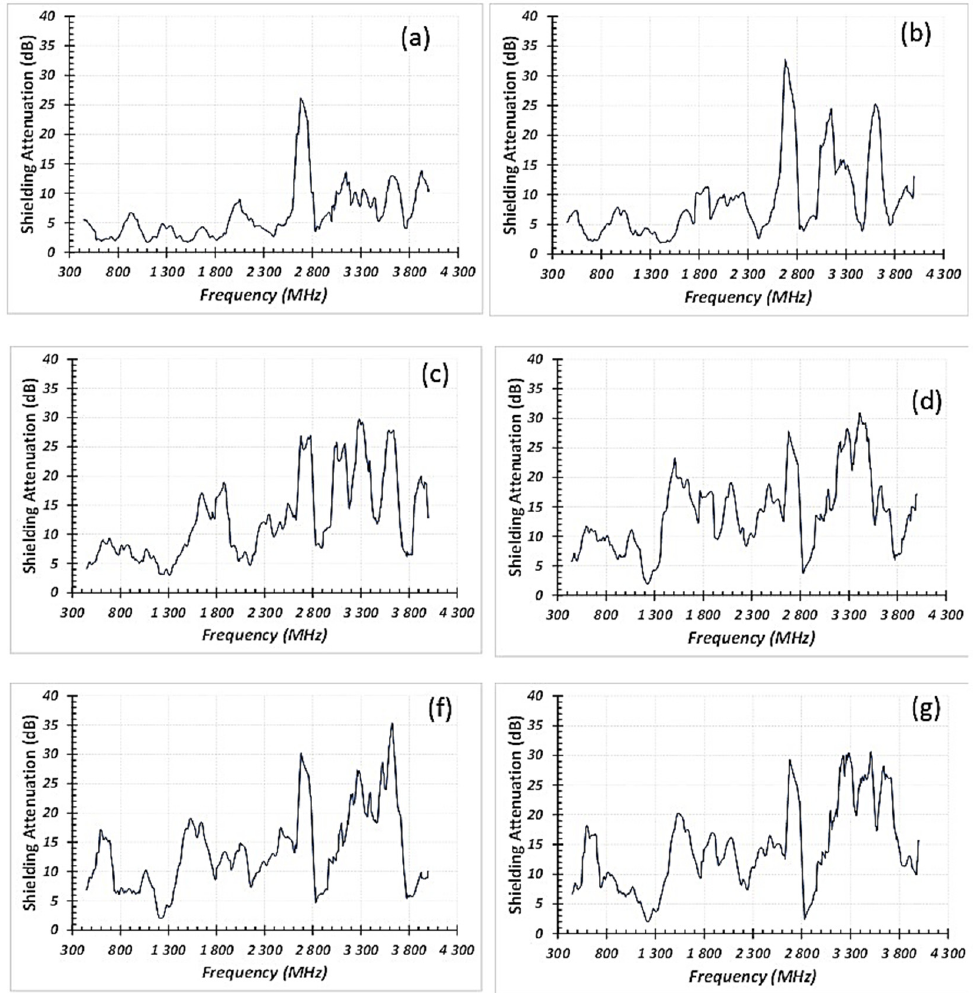
Figure 3. Shielding attenuation for frequency range from 300 MHz to 4000 MHz for coatings with different thickness and composition (listed in Table 2): ( a ) Sample #1; ( b ) Sample #2; ( c ) Sample #3; ( d ) Sample #4; ( f ) Sample #5; ( g ) Sample #6.